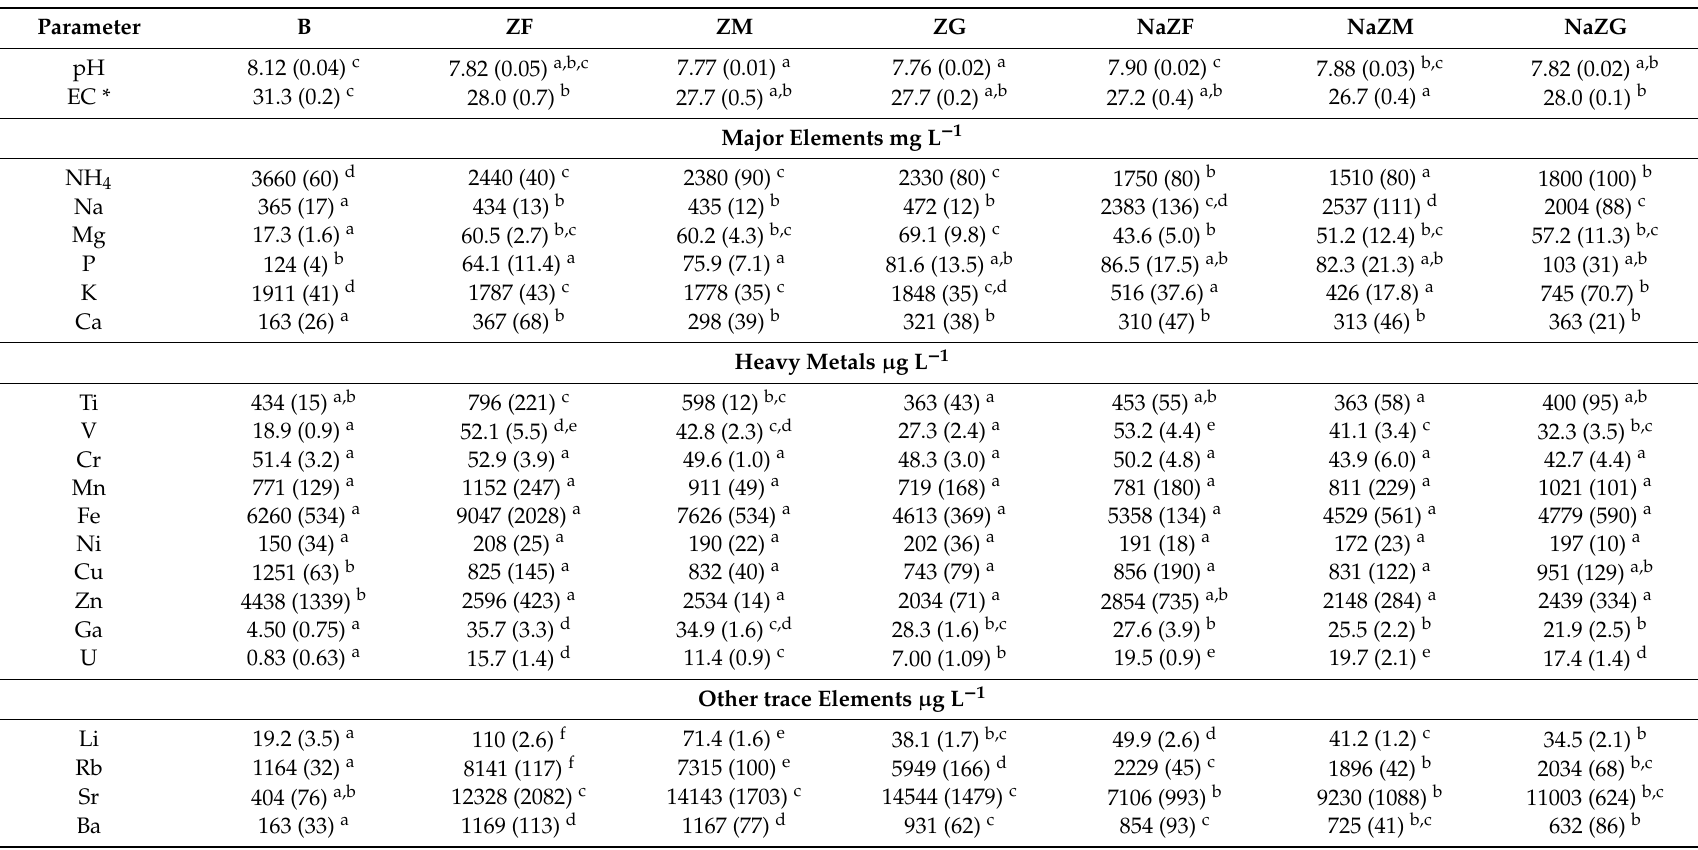
Table A3. Chemical composition of the studied pig-slurry (PS) after the third treatment cycle with natural ZTs (ZF, ZM, and ZG) and Na-exchanged ZTs (NaZF, NaZM, and NaZG) and in blank samples (without ZTs, B). Standard deviation within brackets (three replicates). Di ff erent letters (a,b,c,d,e,f) indicate significant di ff erences obtained from ANOVA and Tukey HSD tests. * Electrical conductivity is reported in mS cm − 1